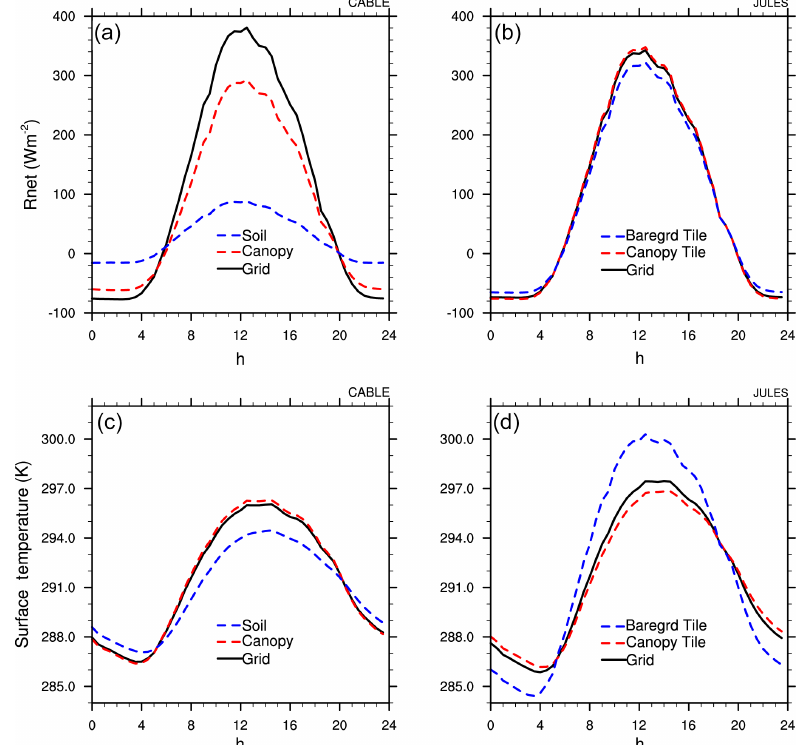
Figure 7. Offline simulation of Hyytiälä, 2002–2005. July mean diurnal cycles of net radiation (Wm − 2 ) for CABLE (a) and JULES (b) and temperature (K) for CABLE (c) and JULES (d) for grid cell (black), vegetation (red), and soil (blue) for CABLE and grid cell (black), vegetation (red), and bare ground (blue) tiles for